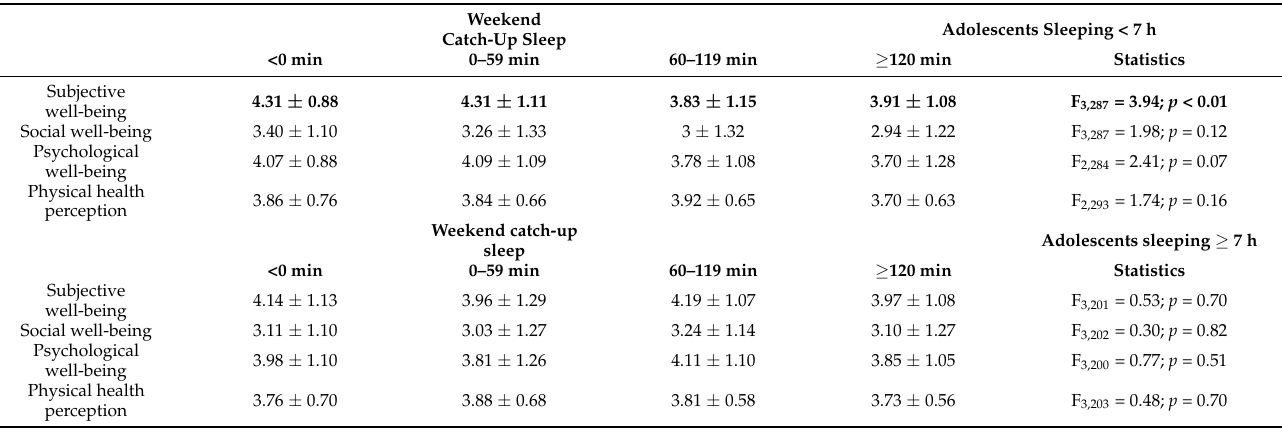
Table 6. Means and standard deviations of subjective, social, and psychological well-being as well as physical health perception according to the extent of the weekend catch-up sleep, separately for sleep duration group. Statistics are also reported, with significant effects in